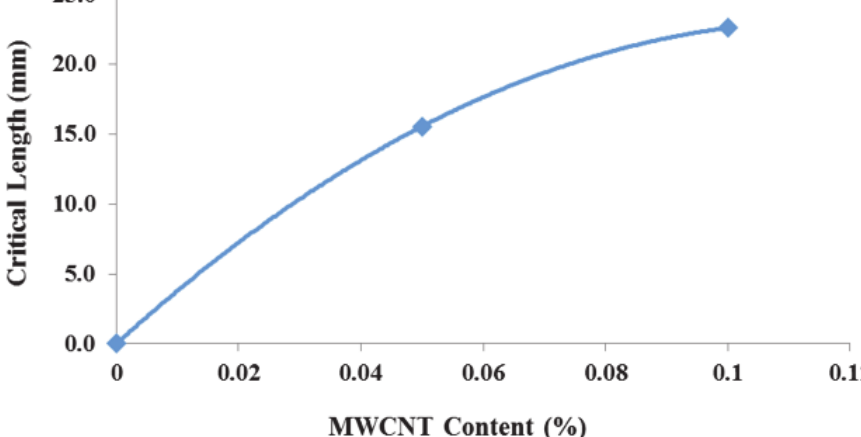
Figure 6 : Relationship of critical pullout length and content of MWCNTs in the concrete matrix.